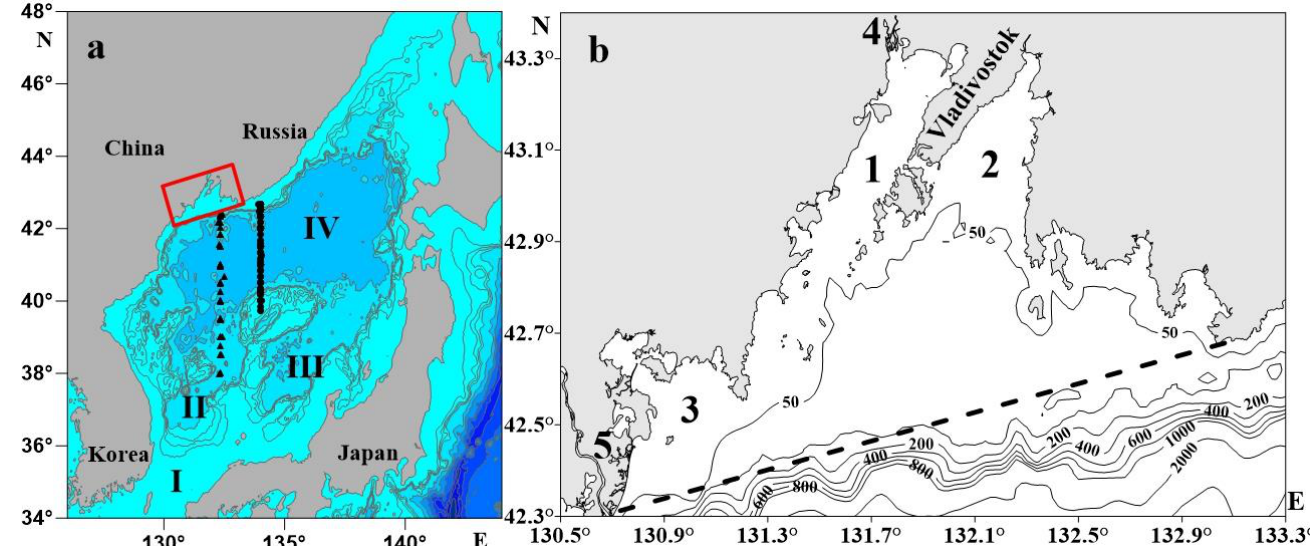
Figure 1. ( a ) Map of the Japan/East Sea (JES), I—Tsushima (Korean) Strait, II—Ulleung, III—Yamato; and IV—Japan deep basins; station locations along 132°20′ E are shown by triangles and along 134°00′ E by circles; the red rectangle shows PGB. ( b ) Map of Peter the Great Bay (PGB); 1, 2, 3—Amursky, Ussuriysky, and Posyet Bays, respectively; 4, 5—Razdolnaya and Tumannaya Rivers, respectively. The dashed line indicates the border of PGB.